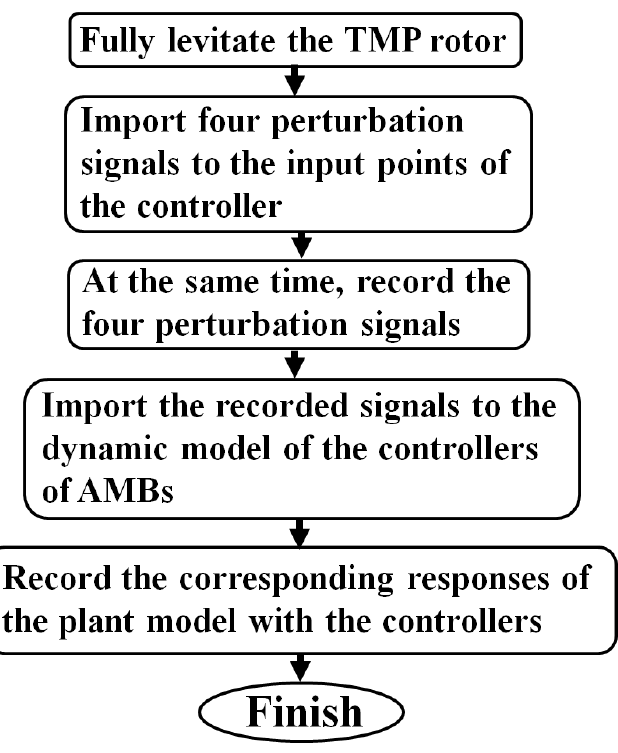
Figure 16. Flowchart of responses generation with perturbation signals.